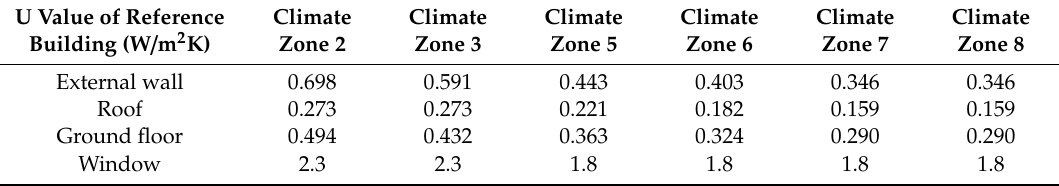
Table 9. U value of reference building envelopes in di ff erent typical cities of the United